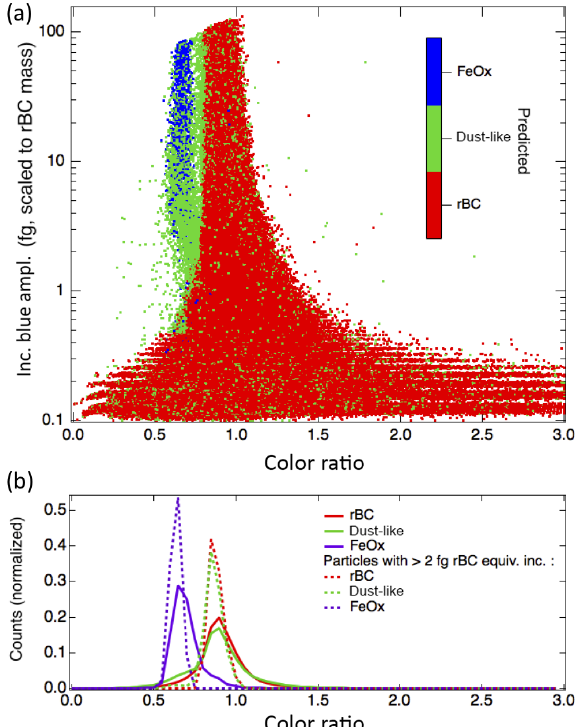
Figure 9. Application of algorithm to observations in Boulder, CO. (a) Ambient data acquired from a rooftop inlet demonstrate the per- formance of the three-class, reduced-feature implementation of the random forest algorithm after it has been trained on laboratory data. A clear feature of FeO x is observed in the ambient data. The larger variety of color ratios at the smaller incandescent peak heights ( < 0 . 5fg rBC equivalent mass) than observed in laboratory data is due to the greater prevalence of small rBC aerosols in the urban environment than in the nebulized fullerene soot samples. (b) His- tograms for the color ratios of the particles identified to belong to each of the three classes are shown, both for the entire population identified and also only for particles with larger incandescent blue